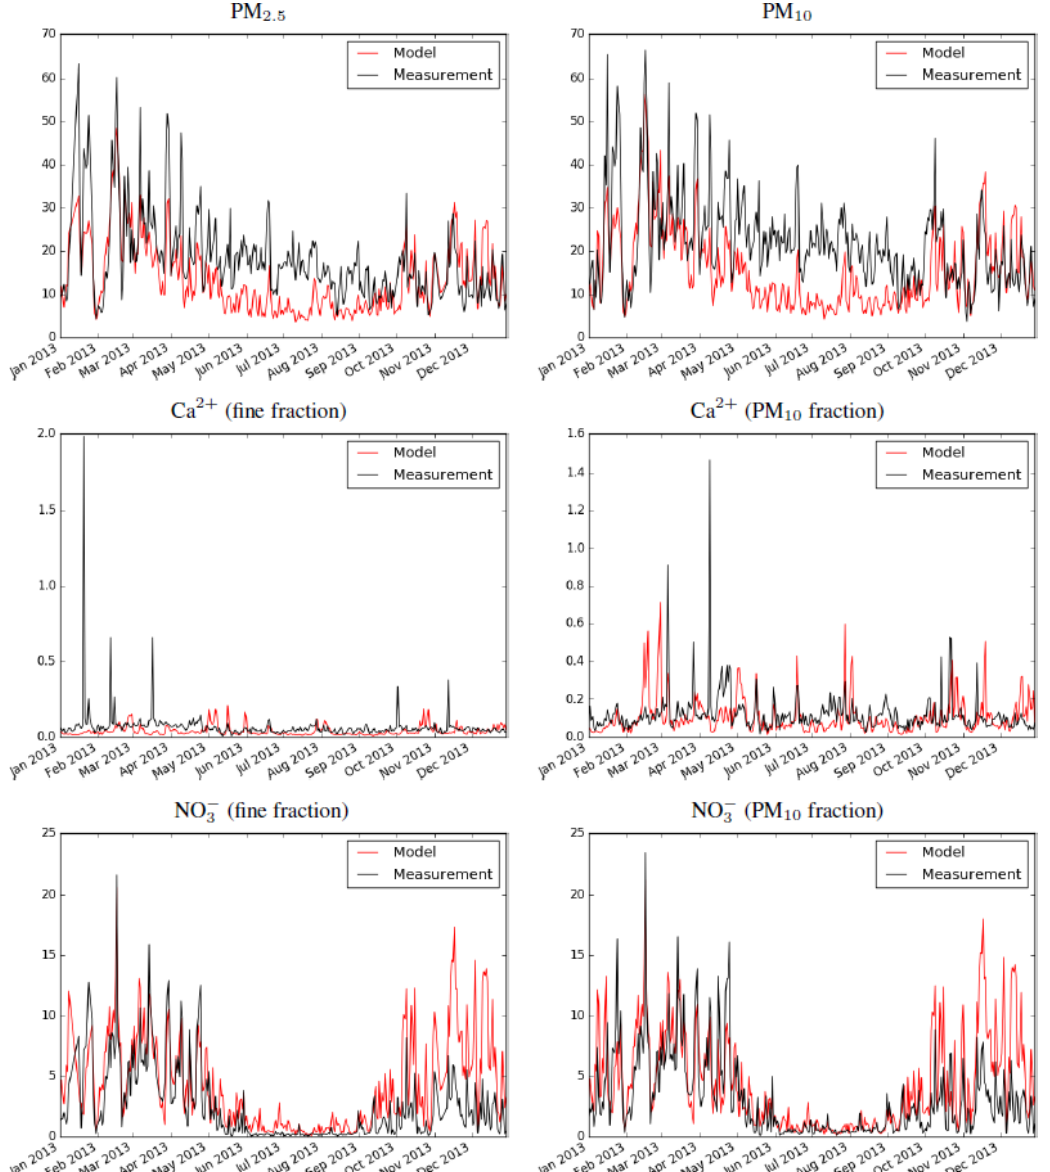
Figure 15. Modeled (red) and measured (black) concentrations of PM 2 . 5 , PM 10 , Ca 2 + (fine fraction and total) and NO − total) in µgm − 3 for station DE0044R